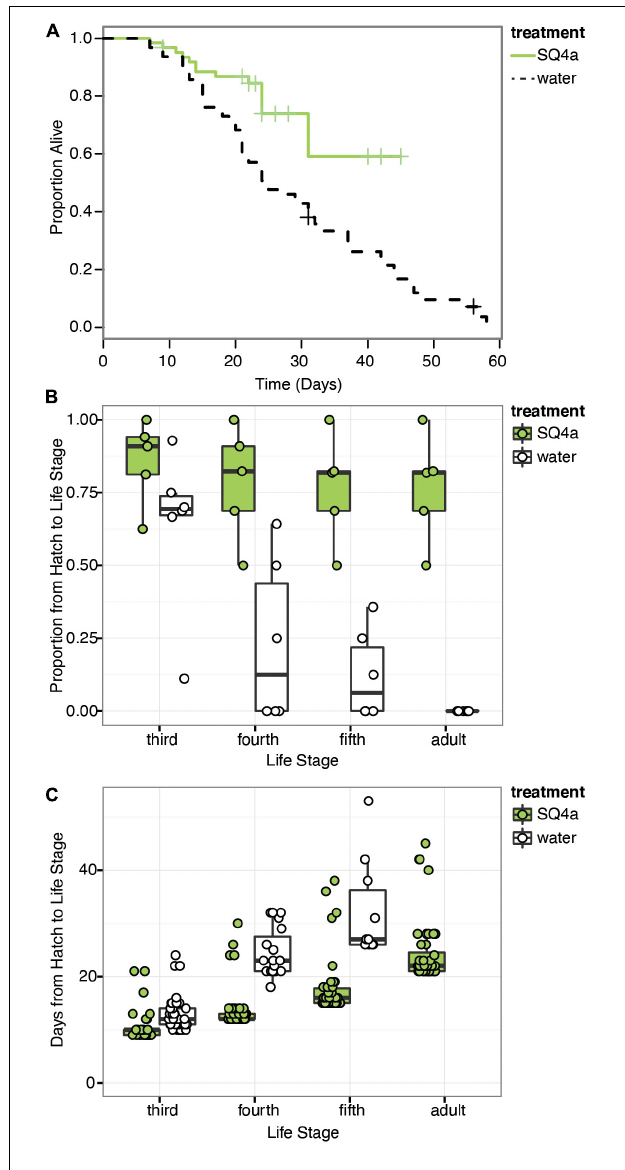
FIGURE 6 | Caballeronia sp. SQ4a association increases survival and decreases development time when squash bugs are reared on